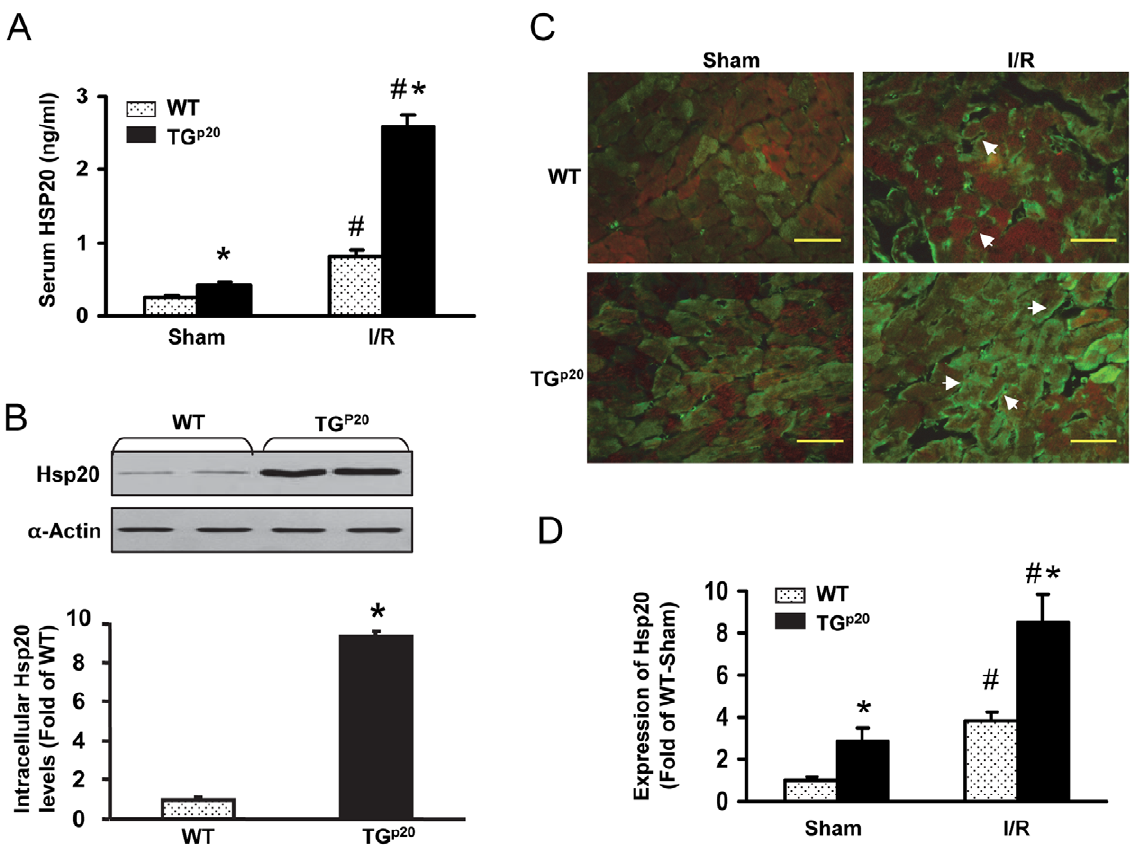
Figure 1. Hsp20 is secreted from cardiomyocytes invivo . (A) The serum Hsp20 level was increased in response to in vivo 30 min-LAD occlusion followed by 24 h-reperfusion. Cardiac-specific overexpression of Hsp20 increased the Hsp20 concentration in the serum under basal and myocardial ischemia/reperfusion conditions. (n=6; *, p , 0.05 vs. WTs; # , p , 0.05 vs. Sham groups). (B) The levels of Hsp20 in hearts from Hsp20-transgenic mice were determined by Western blot. a -Actin was used as an internal control (n=4). (C) Myocardial ischemia/reperfusion stimulated the translocation of Hsp20 to the cardiomyocyte membrane, which was detected by fluorescence microscopy. Images are representative sections from four mice per group (green, Hsp20; red, a -Actin; Scale bar, 100 m m). (D) Quantitative data for expression of Hsp20 was evaluated using IPP 5.1 (n=4; *, p , 0.05 vs. WTs; # , p , 0.05 vs. Sham groups).